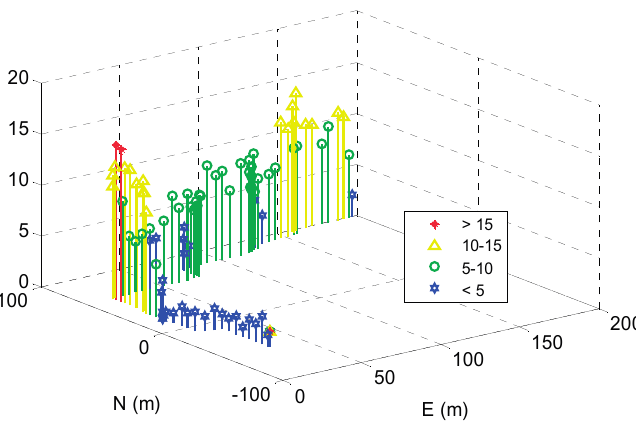
Figure 17. WiFi signal distribution in the reference DB.